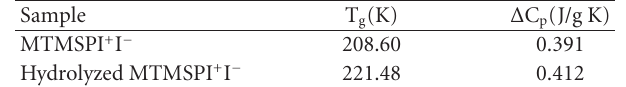
Table 1: T g values of nonhydrolyzed and hydrolyzed (0 . 1M HCl) MTMSPI + I − .